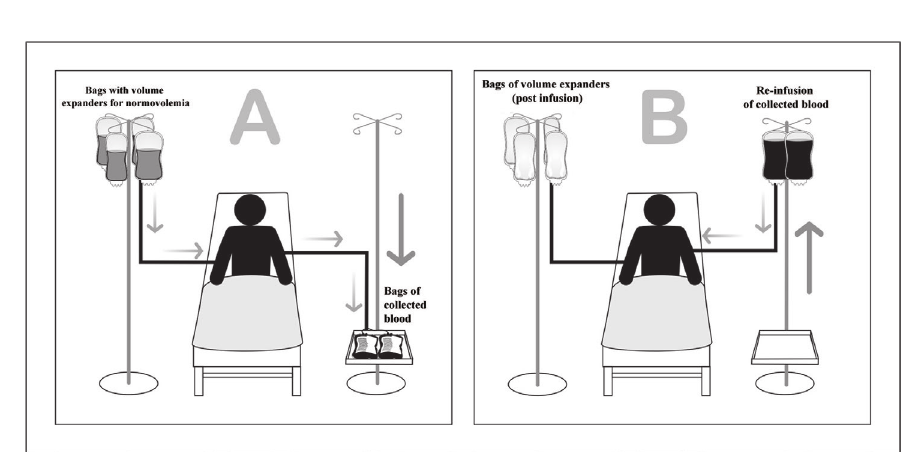
Fig. 3 - Schematic representation of acute normovolemic hemodilution. (A) Bags of blood being removed immediately before the initiation of surgery, along with the infusion of volume expanders to maintain normovolemia. (B) Bags of blood being re-infused during and/or immediately after the surgery is completed.